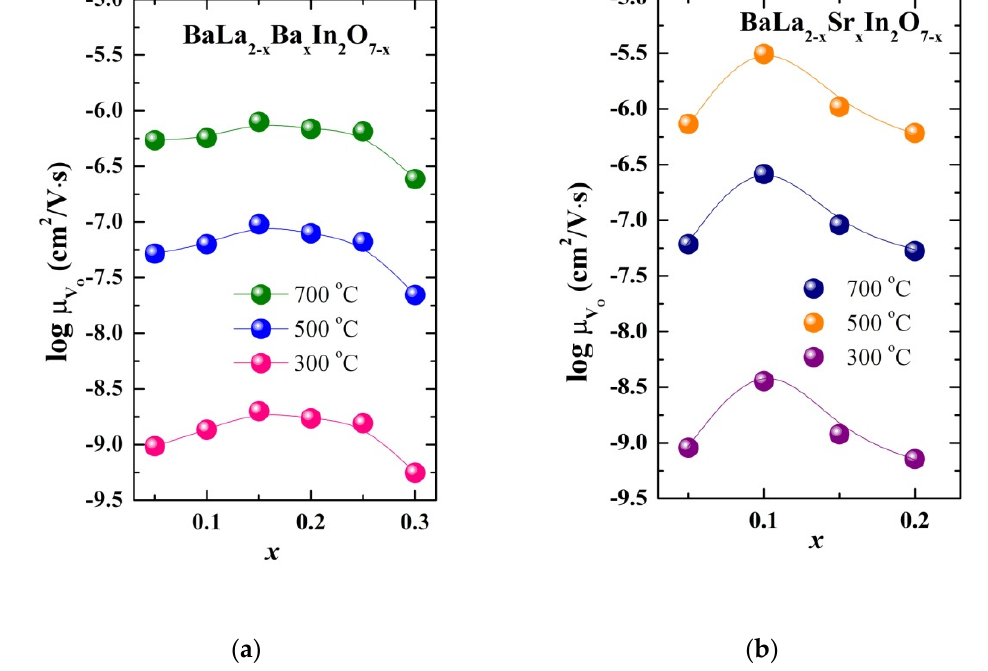
Figure 8. The concentration dependencies of oxygen ions mobility at 700, 500, and 300 °C for the solid solutions BaLa 2 − x Ba x In 2 O 7 − 0.5 x ( a ) and BaLa 2 − x Sr x In 2 O 7 − 0.5 x ( b ).